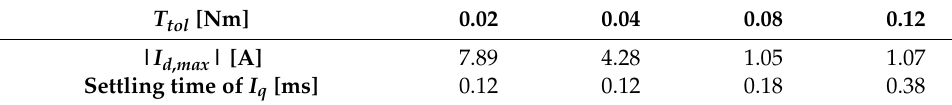
Figure 8. The current of d and q axes with different torque tolerance. ( a ) T tol = 0.02 Nm, ( b ) T tol = 0.04 Nm, ( c ) T tol = 0.08 Nm, ( d ) T tol = 0.12 Nm. Table 3. Influence of T tol on the control performance.